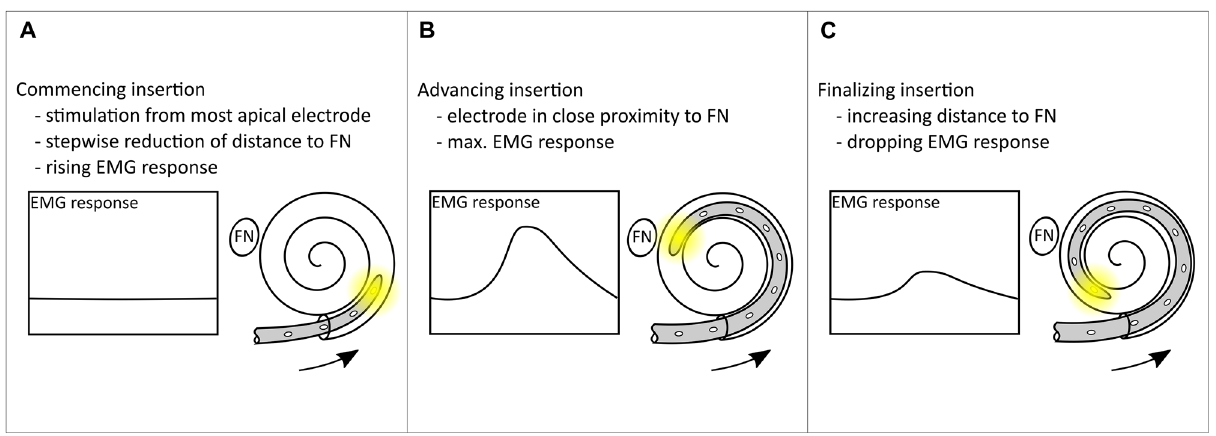
Figure 2. Schematic illustration of the real-time measurements. EMG activity is recorded during the stepwise insertion of the cochlear implant electrode array. Panels ( A , B , and C ) illustrate three different stages of the measurements procedure. The facial nerve is indicated by the abbreviation